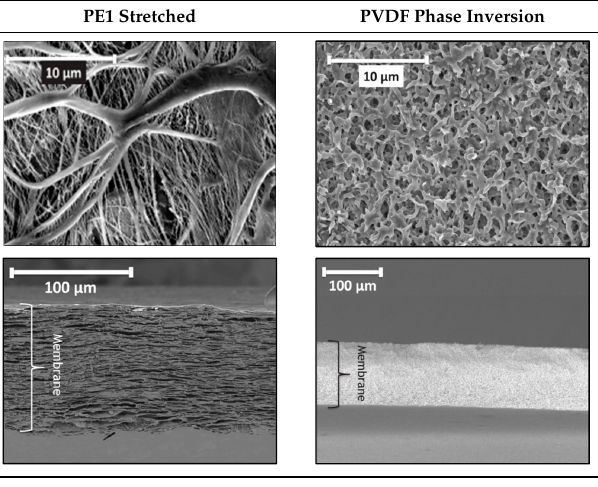
Table 3. Surface and cross-section images of the commercial polyethersulfone (PES) membrane and properties obtained using image SEM